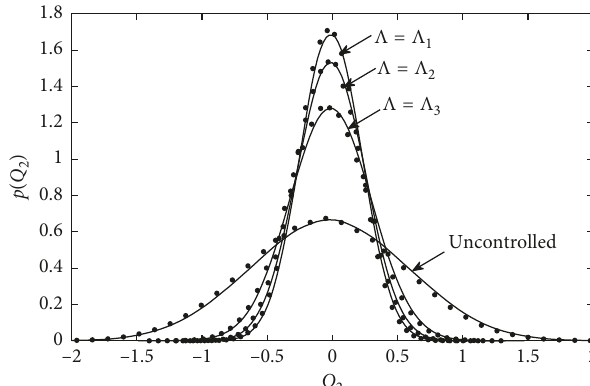
Figure 2: The stationary probability density p ( Q of the first oscillator of optimal controlled system compared with uncontrolled system. The lines are obtained by proposed method, while the dots are obtained from Monte Carlo simulation of the original system (24).